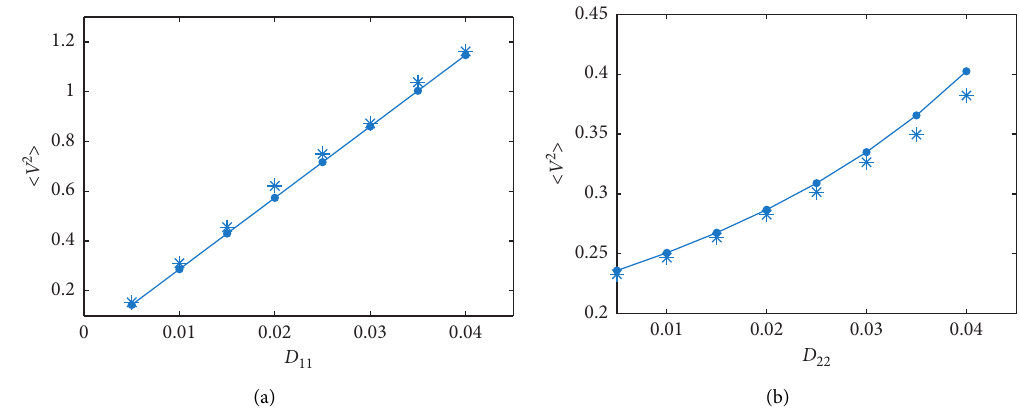
Figure 4: The influences of noise intensity on the MSEV. Theoretical analysis results (solid round) and Monte Carlo simulation results ( ∗